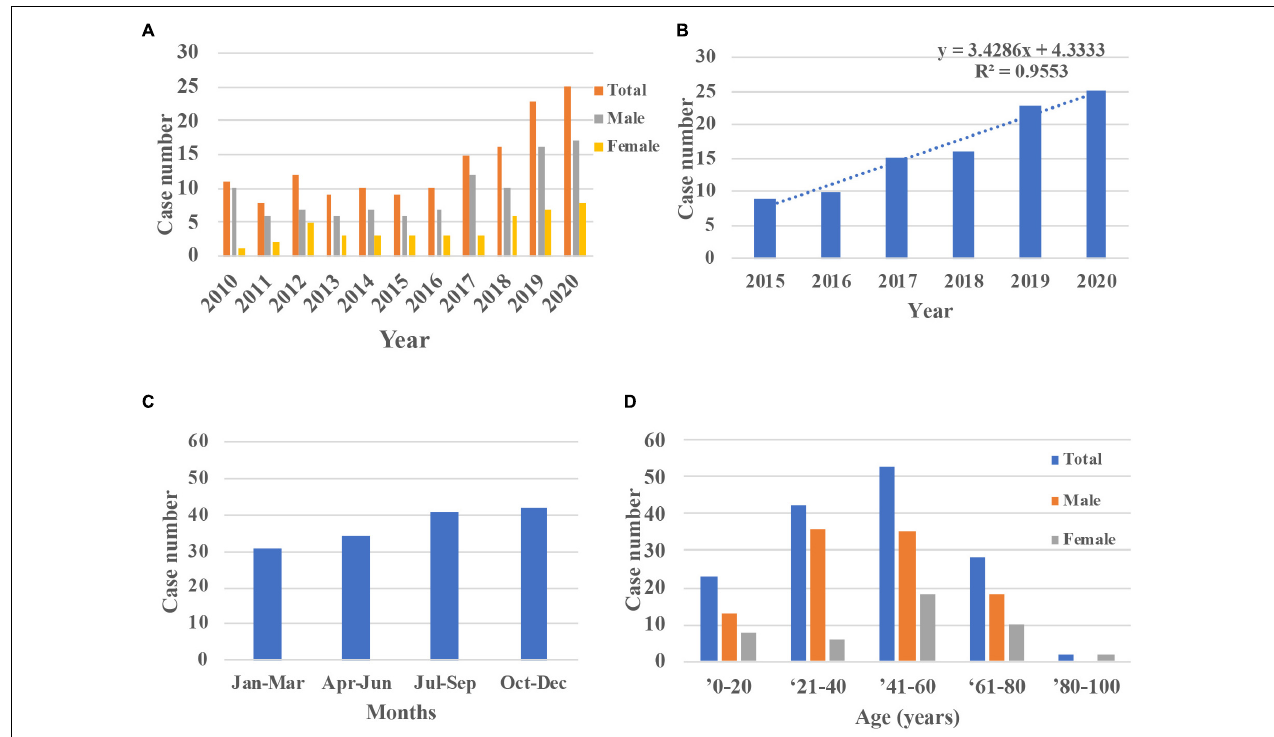
FIGURE 2 | Demographic characters of inpatients with OC during 2010 and 2020. (A,B) The case numbers were similar in the first 5 years but increased in the last 5 years ( R = 0.96). (C) The distributions across seasons did not differ significantly ( P = 0.50). (D) The largest number of cases of OC occurred among patients aged 40–60 years and most patients were male. OC, orbital cellulitis.